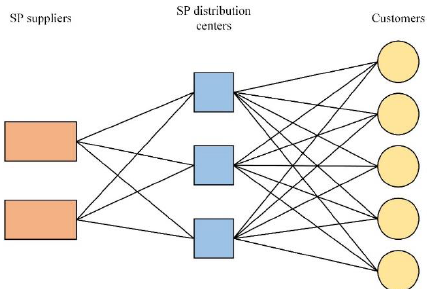
Figure 1. The basic spare part supply chain